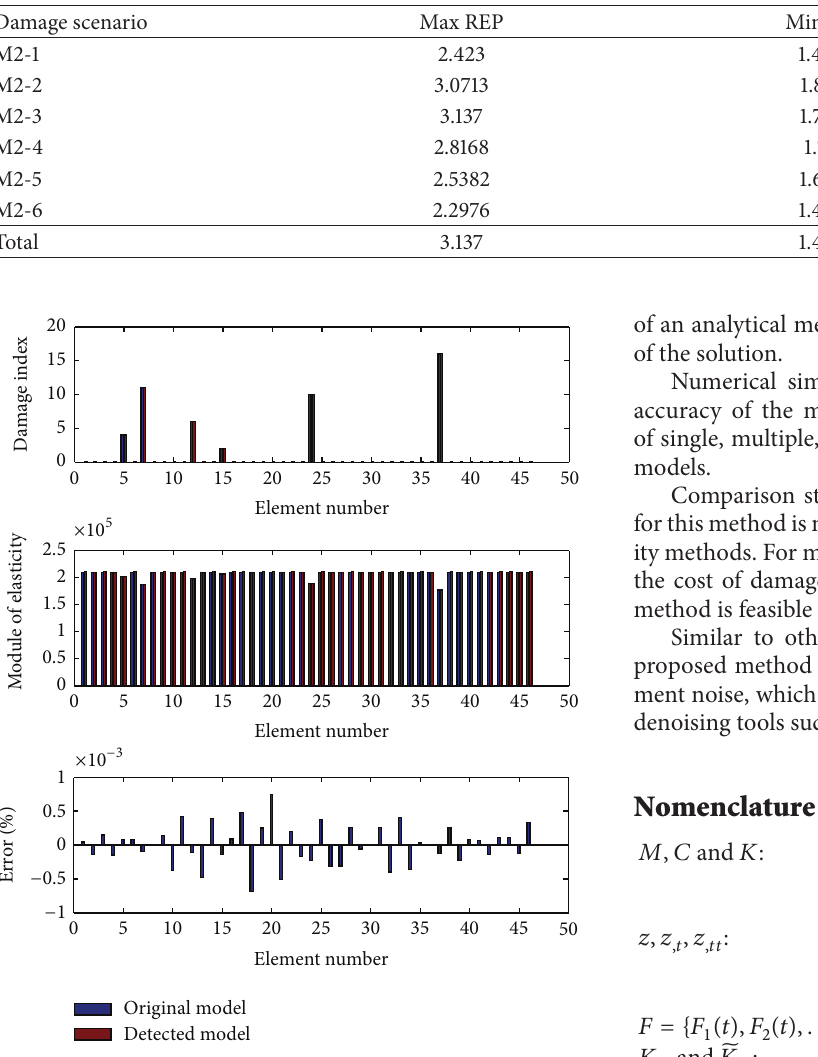
Figure 9: Detection of damage location and amount in elements 5, 7, 12, 15, 24, and 37 and distribution of error in different elements with ADM